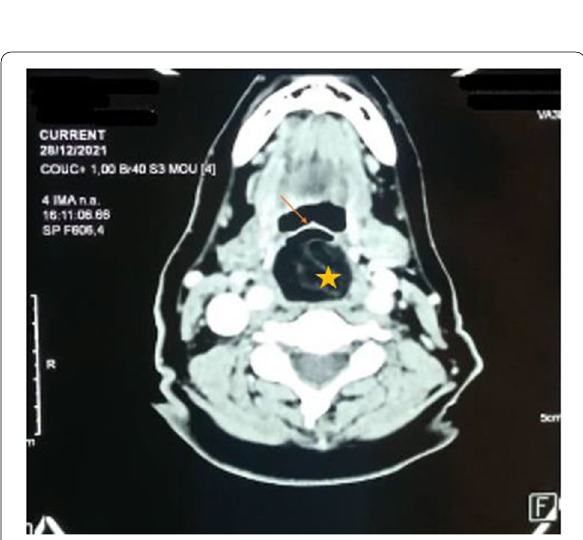
Fig. 2 Cervical CT scan C tract obstructive lipoma